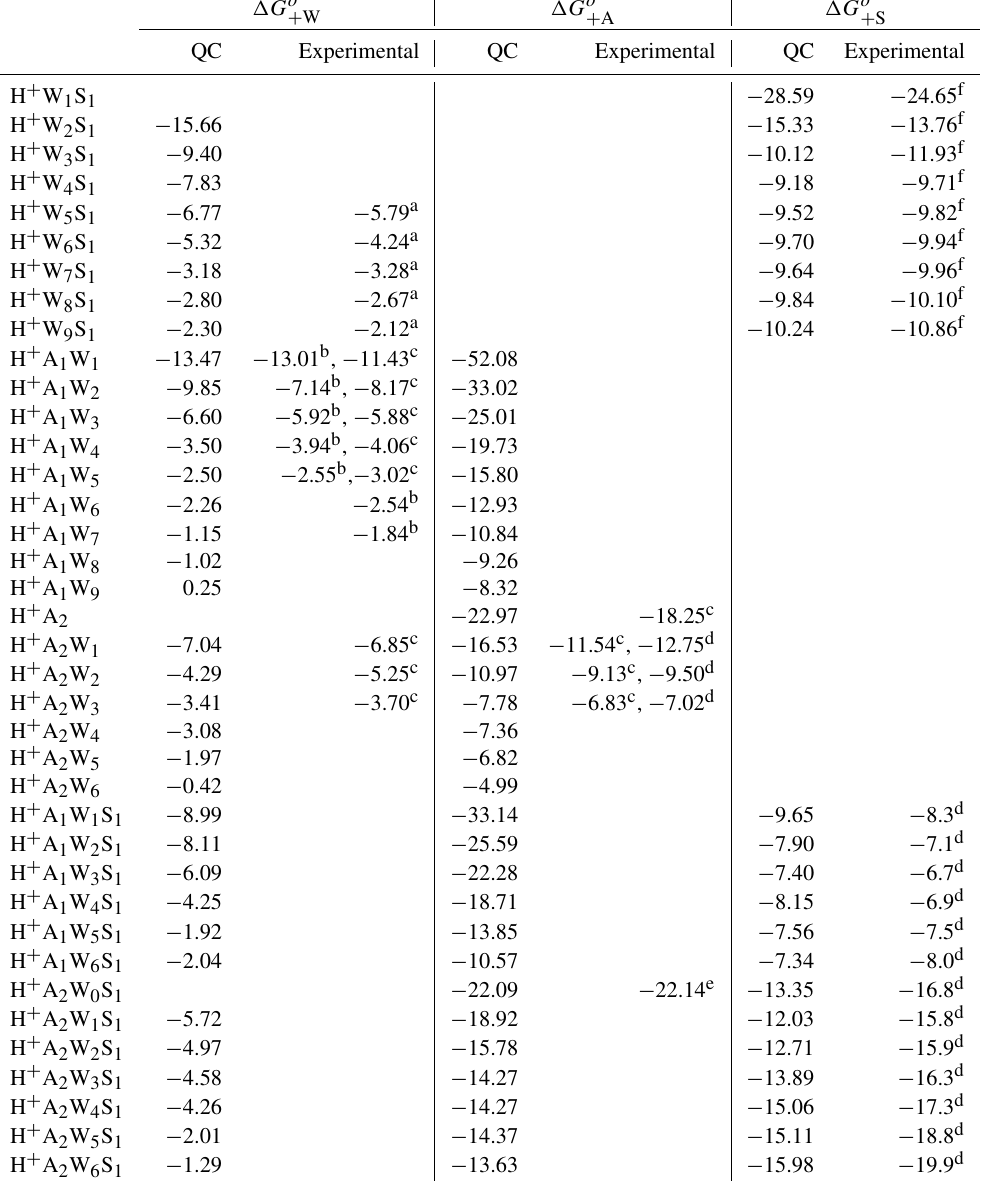
Table A2. QC-based stepwise Gibbs free energy change (kcalmol − 1 ) for the addition of one water ( (cid:49)G o + acid ( (cid:49)G o + ) molecule to form the given positively charged clusters under standard conditions and the corresponding experimental data or S semi-experimental